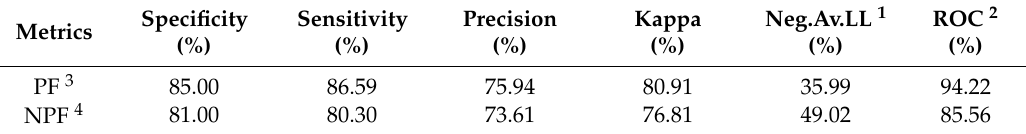
Table 2. Accuracy assessment of discriminating landslide-a ff ected objects from non-landslide-a ff ected objects derived from Sentinel-1A, Sentinel-2A, and DEM using object-oriented random forest in the protected forests and non-protected forests in NE